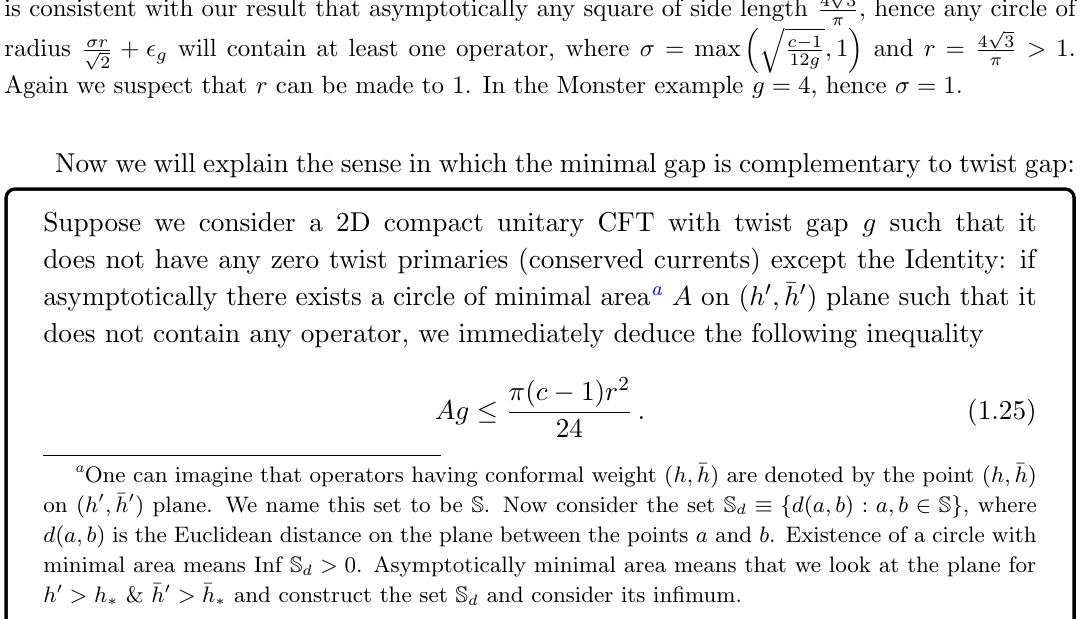
. Thus any circle 2 p 3 , hence any circle of (cid:25) p (cid:16)q (cid:17) 3 c (cid:0) 1 ; 1 and r = 4 > 12 g (cid:25)